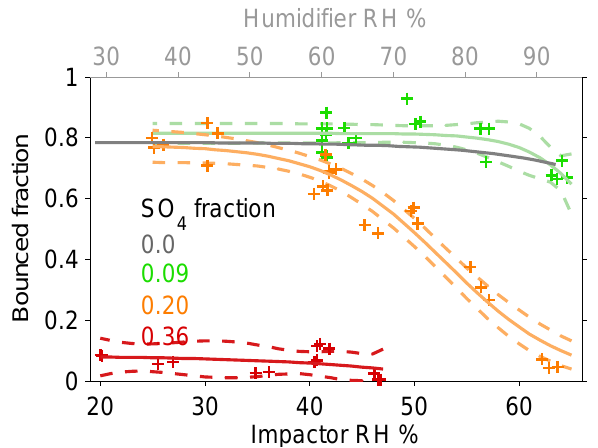
Fig. 5. Addition of SO 2 to precursor flow for longifolene SOA ex- periment decreases the phase transition relative humidity. The SO 4 fraction indicates the fraction of SO 4 with respect to the total mea- sured AMS mass (ORG+SO 4 +NO 3 +NH 4